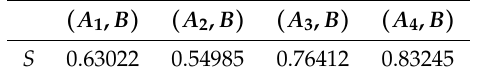
Table 3. The proposed similarity measure S